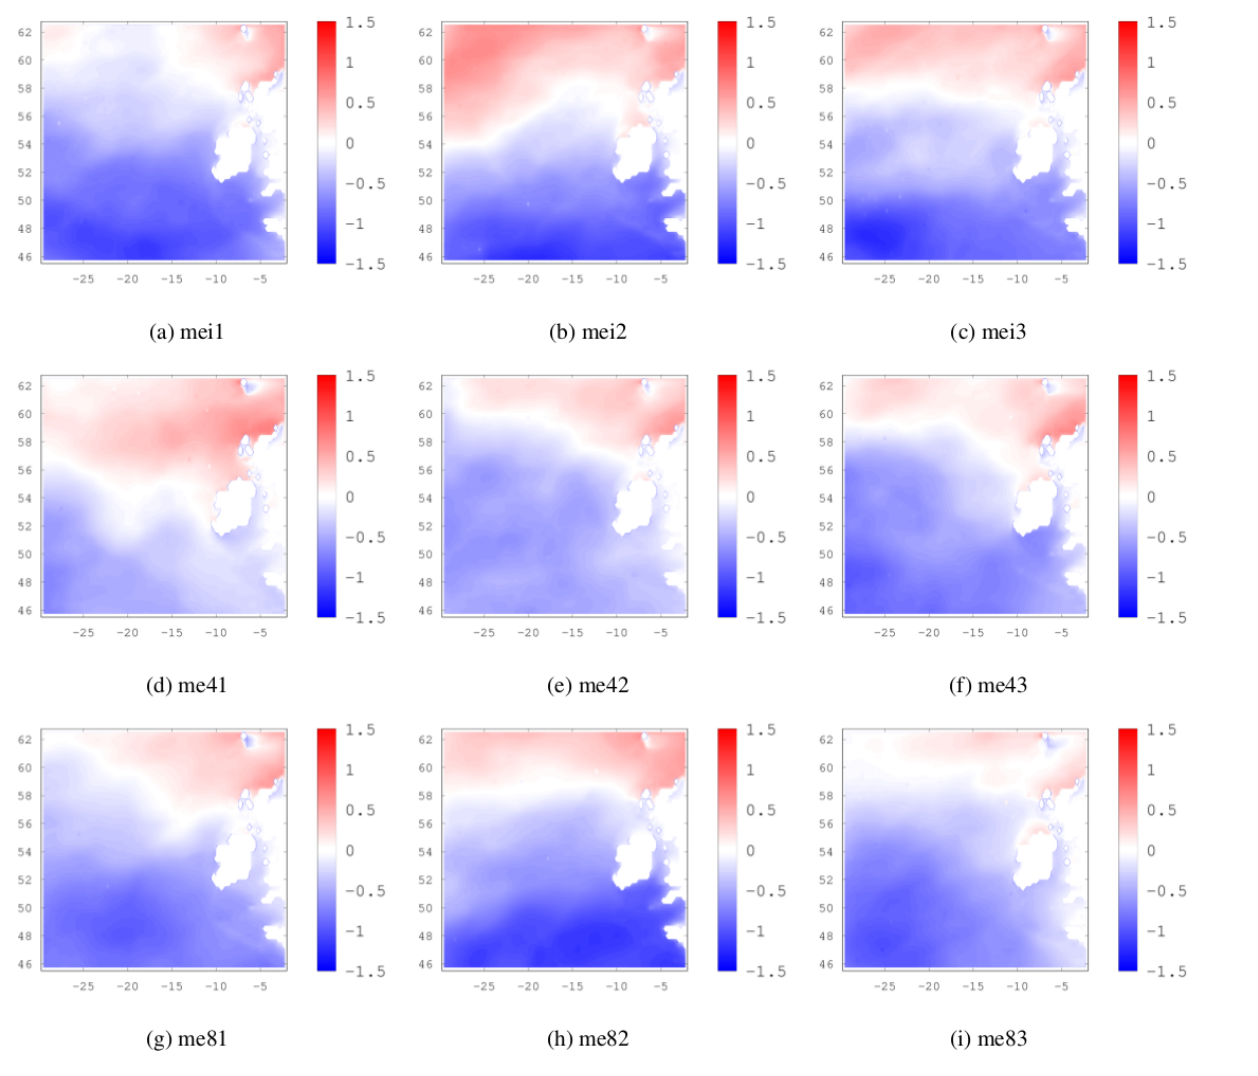
Figure B1. Maximum likelihood estimate of the µ 2 parameter. The three ensemble members are shown for the historical period (a) to (c) , future period under RCP4.5 (d) to (f) , and future period under RCP8.5 (g) to (i)